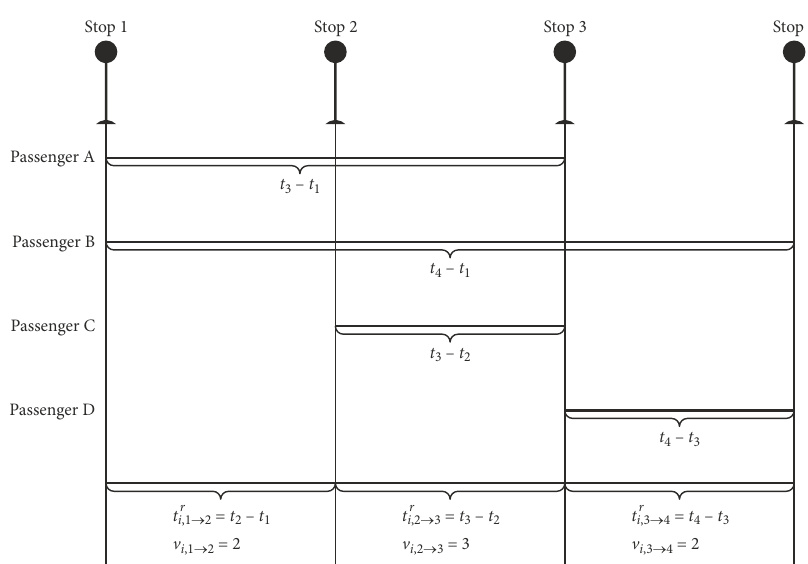
Figure 6. Passenger travel time